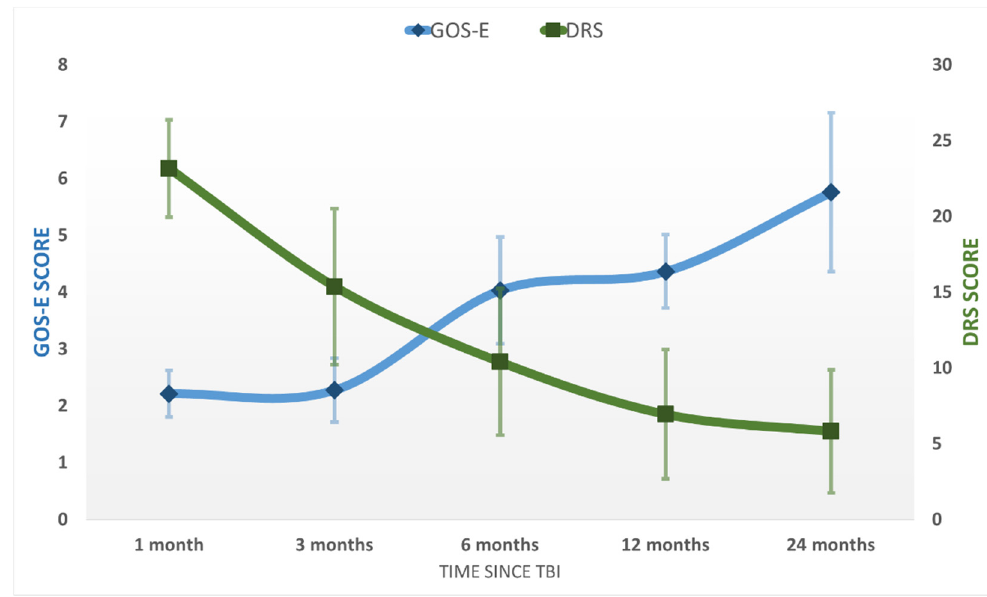
Figure 2. The average GOS-E and DRS scores in the study population at the five evaluations after the TBI. Error bars represent the standard deviation.